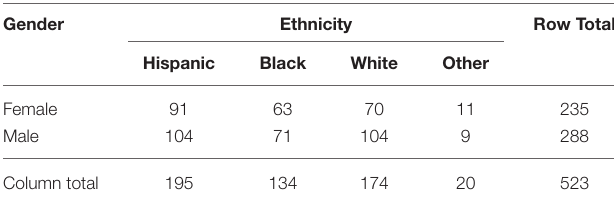
TABLE 1 | Cross-tabulation of participant demographic frequencies by ethnicity and